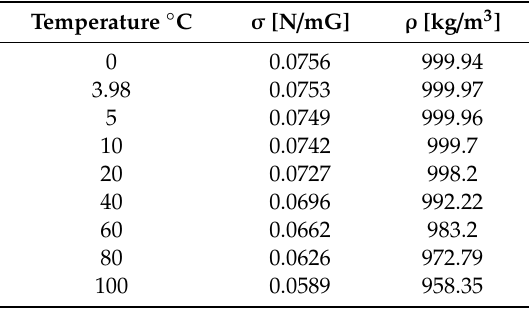
Table 1. Changes in surface tension and water